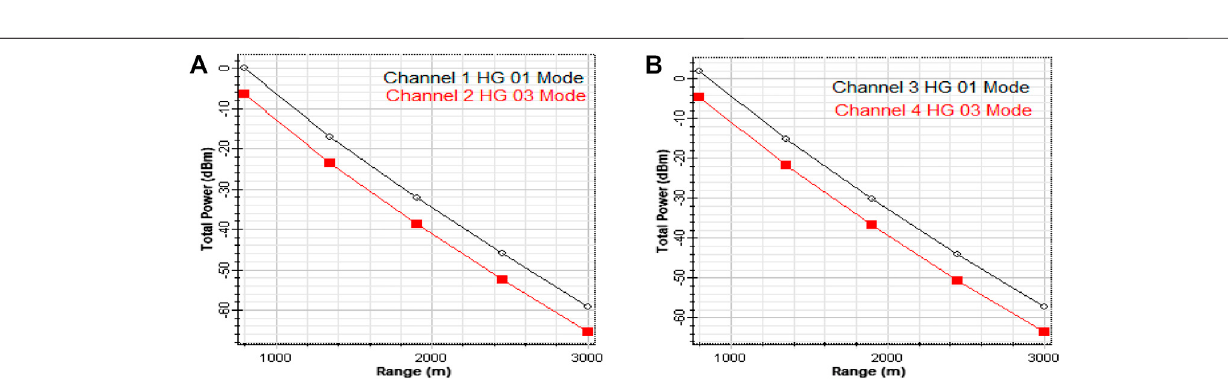
FIGURE 9 | Signal power plots for (A) 1931. THz channel and (B) 193.2 THz channel under low fog.